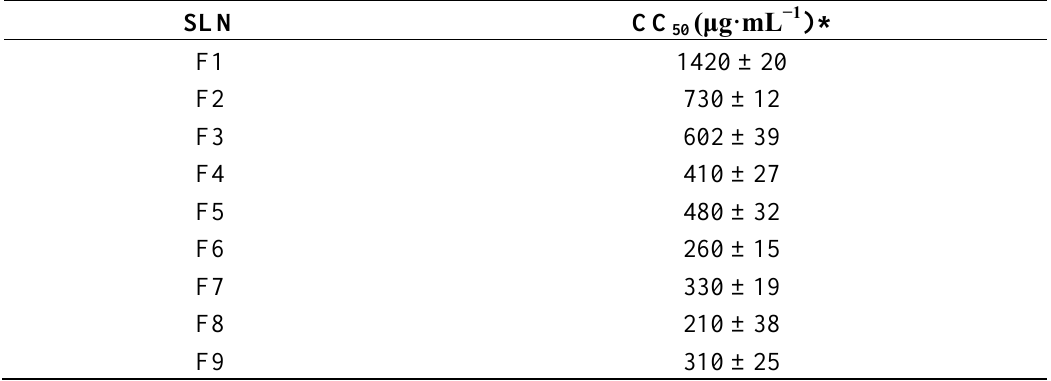
Table 3. CC of SLN in fibroblast cells 50